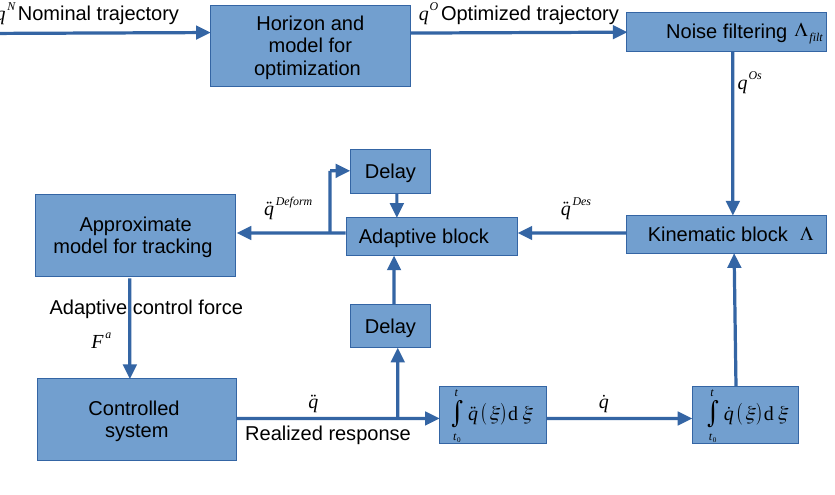
Figure 2. The flow chart of the controlling